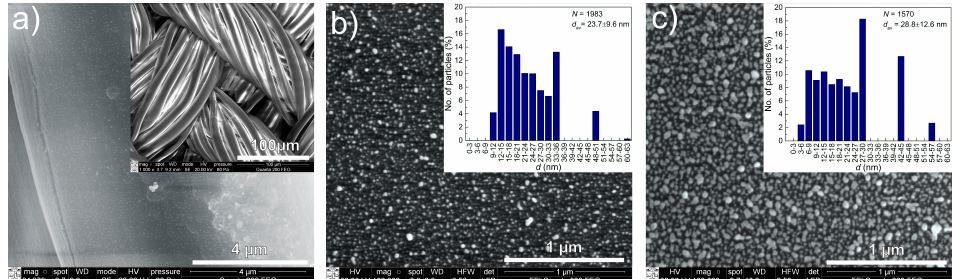
Figure 1. SEM micrographs of DLC:Ag films of different Ag content on different substrates: ( a ) lowest Ag content film (Sample 1; scale bar: 4 µ m) on silk; the inset depicts the silk structure (scale bar: 100 µ m); ( b , c ) summarize the information about the medium and highest Ag concentration film (Samples 2 and 3, respectively; scale bar: 1 µ m) on silicon substrates; insets depict the particle size distribution number of analyzed particles ( N ) and the average particle diameters ( d av ) of the corresponding SEM